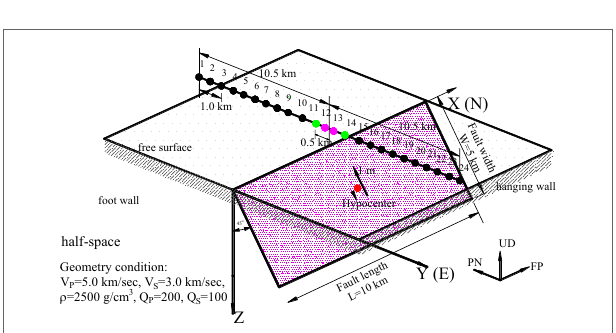
FigUre 9 | Dip-fault model with surface faulting with 24 observation points